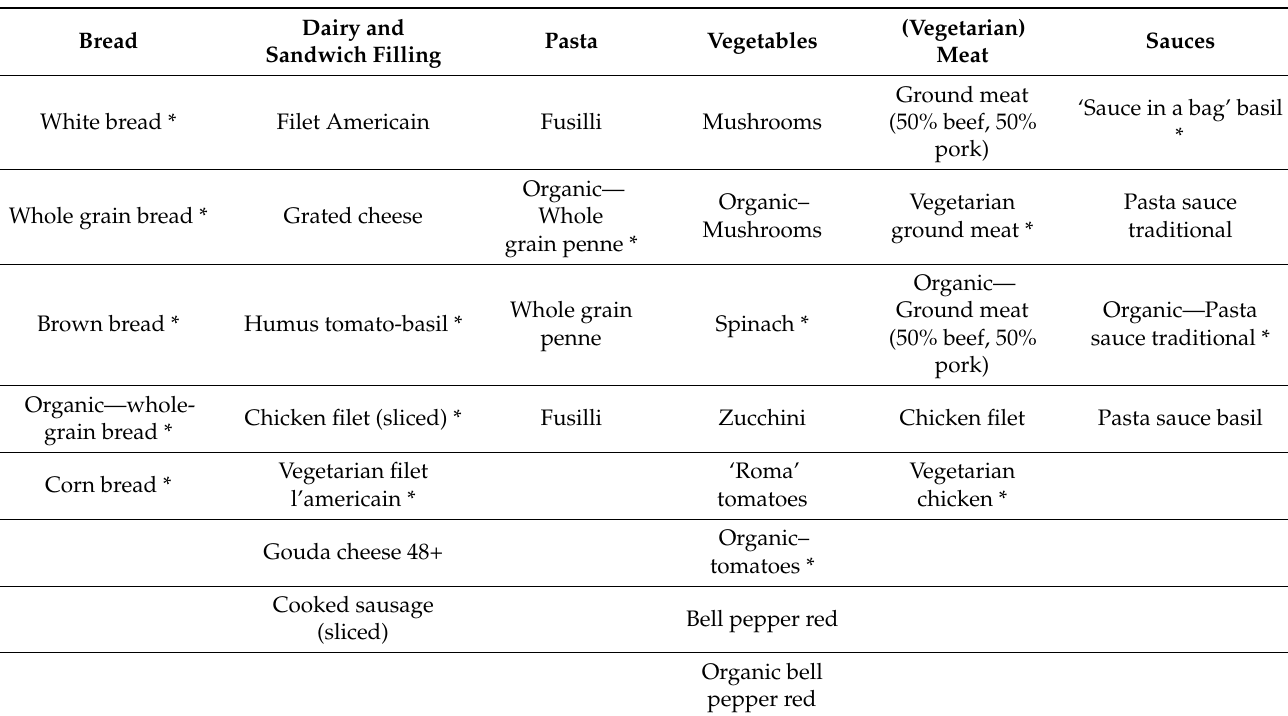
Table 2. Product categories and products included in the online